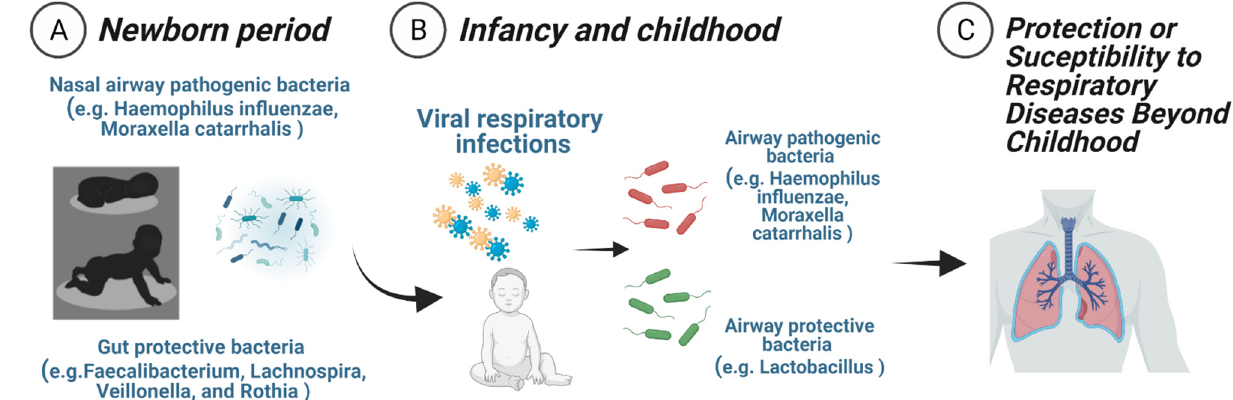
Figure 2. Early microbial–immune interactions modulate risk against respiratory diseases. Early microbial–immune interactions include ( A ) the newborn period (3 months), during which initial bacterial colonization of the nasal airways and gut are essential to shape respiratory immunity, and ( B ) infancy and early childhood (first 2–3 years of life), where transient microbiome changes during viral respiratory infections are linked to distinct airway immune responses and respiratory outcomes. ( C ) The events occurring during these periods of innate immune training play a crucial role in the development of asthma and other respiratory conditions beyond childhood.